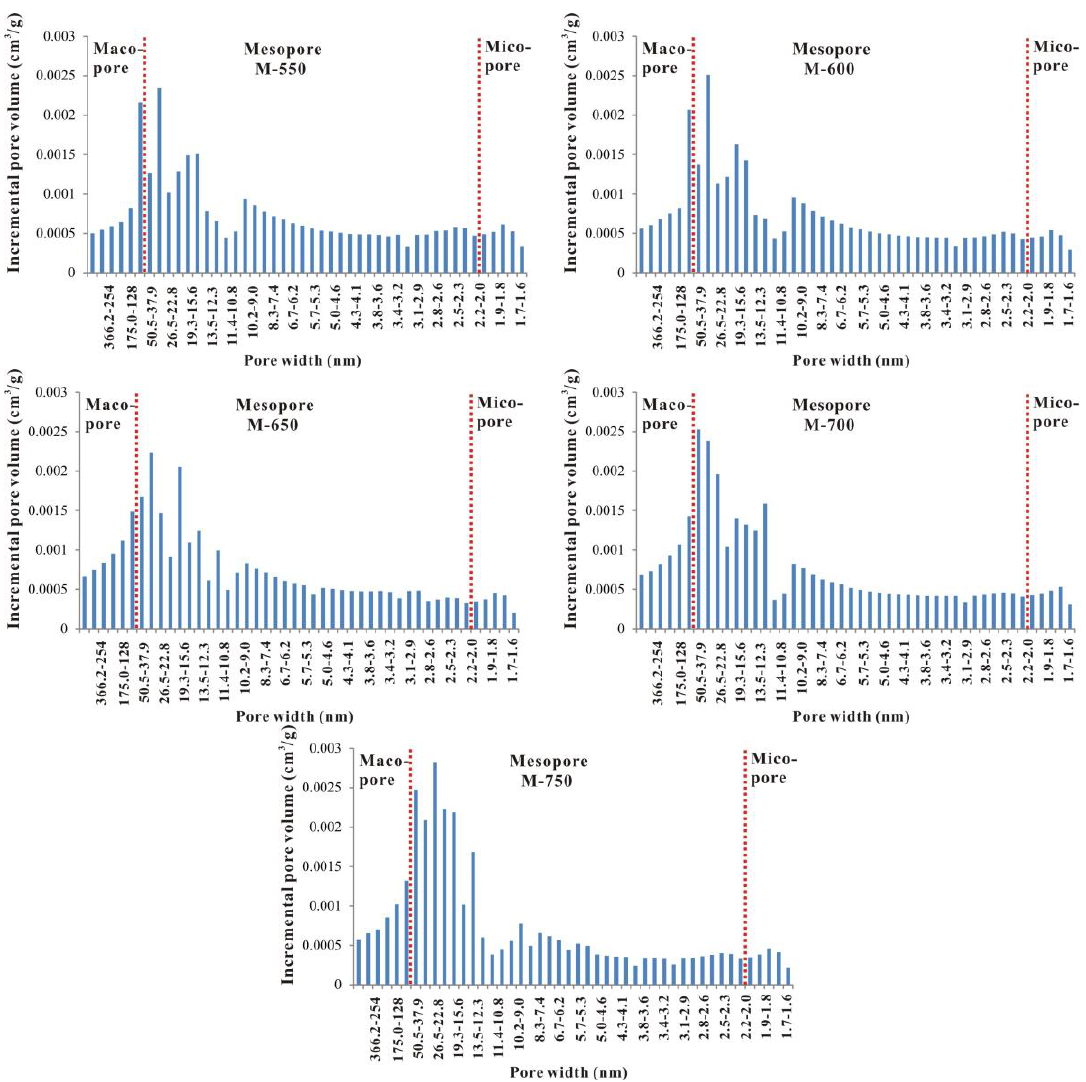
Figure 6. Pore size distribution derived from N 2 adsorption for the shale samples at different temperatures.